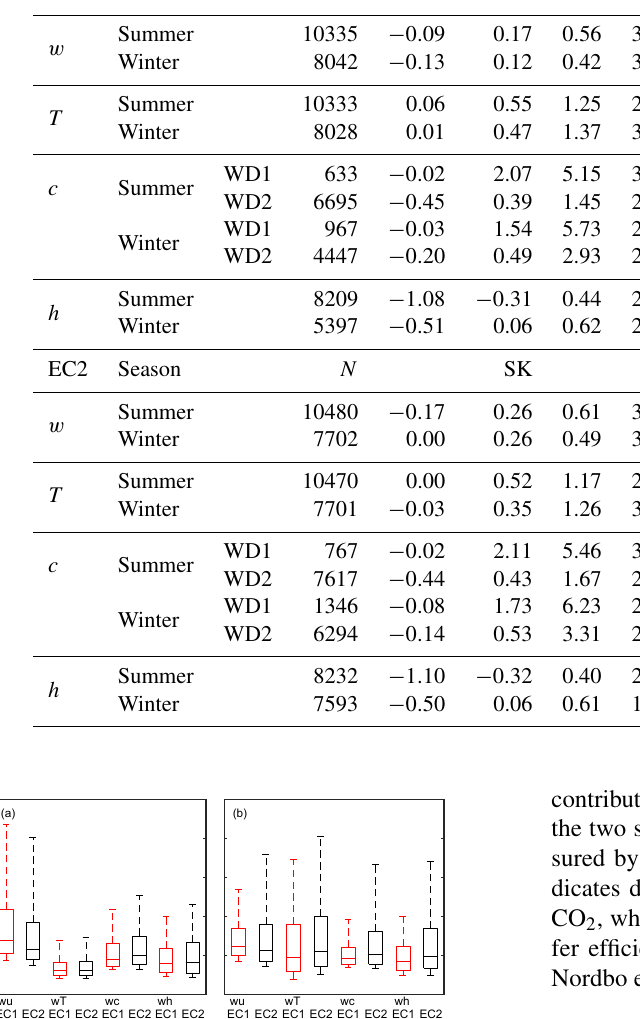
Figure 6. Relative random error (RRE) for (a) daytime (solar ele- vation angle > 0 ◦ ) and (b) night-time (solar elevation angle ≤ 0 ◦ ) momentum ( wu ), heat ( wT ), CO 2 ( wc ) and water vapour ( wh ) co- variances from the two systems EC1 and EC2 outside the flow dis- tortion sectors. Whiskers and boxes represent the 10th, 25th, 50th, 75th and 90th